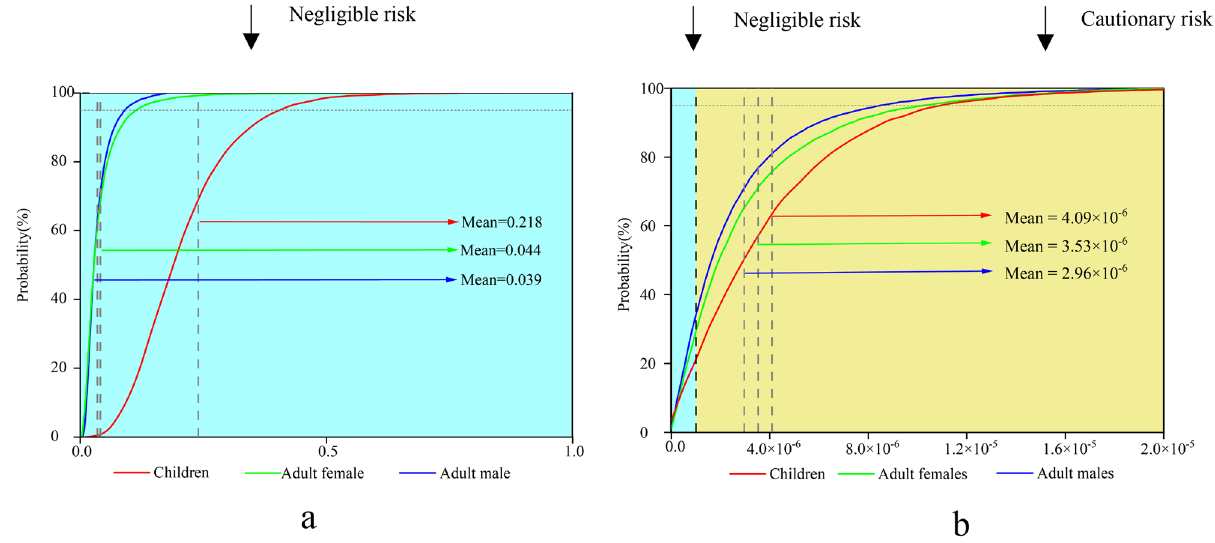
Figure 3. Distribution for TCR and HI: ( a ) total carcinogenic risk (TCR); ( b ) hazard index (HI). Software: Origin2021. URL: https:// www. origi nlab. com/.